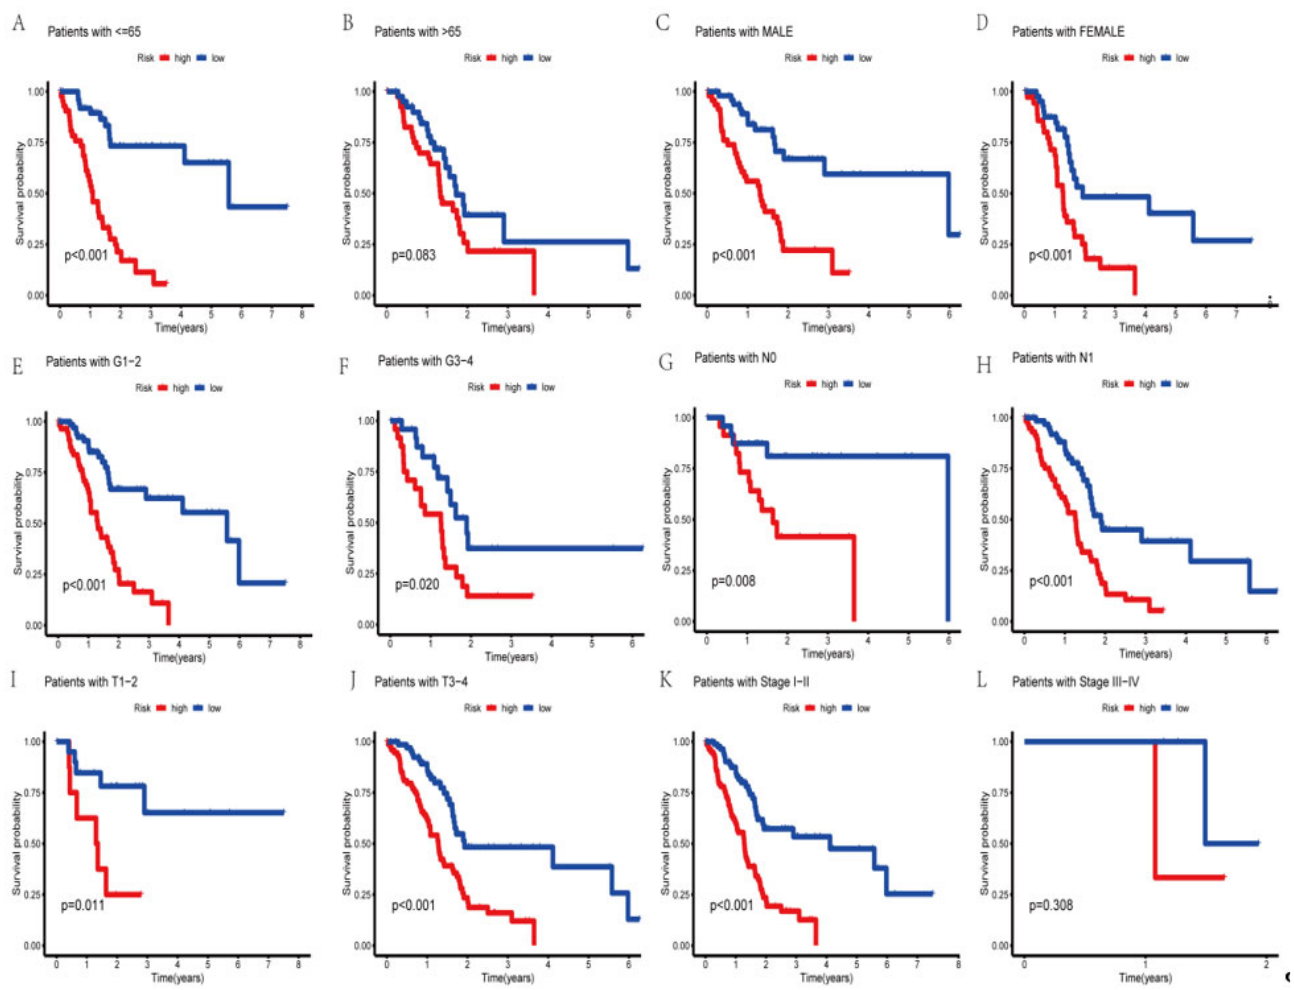
Figure 5. The Kaplan–Meier curves of PAAD patients in the low-risk and high-risk groups, in the context of different characteristics.